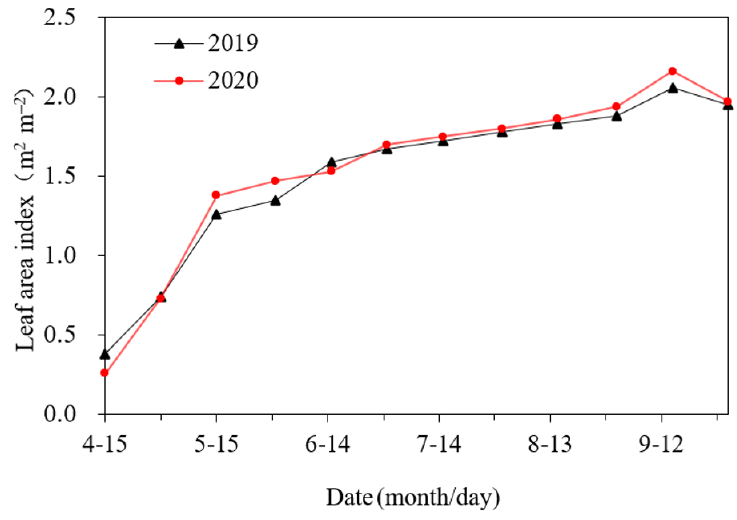
Figure 3. Dynamics of leaf area index during apple tree growth period in 2019 and 2020.